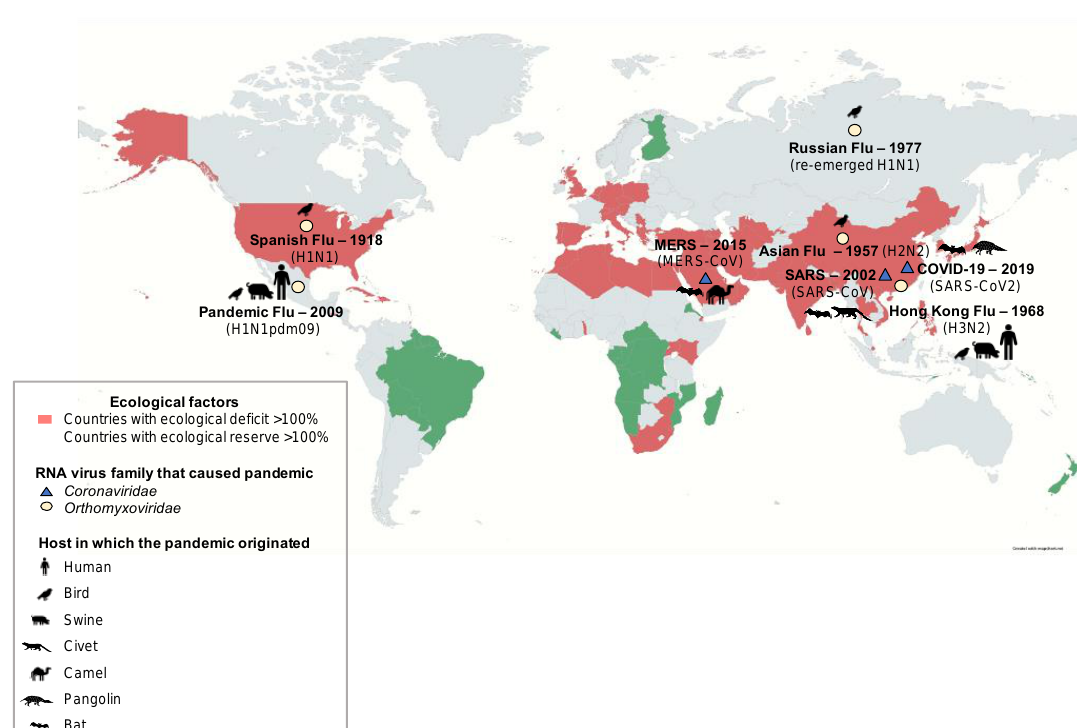
Figure 1. Countries with a percentage greater than 100% of ecological deficit (red) and countries with ecological reserve (green). The map indicates countries of origin of pandemics caused by RNA-genome viruses that belong to Coronaviridae (blue triangle) and Orthomyxoviridae (yellow circles) families. In the parenthesis are the viruses accountable for pandemics and pictograms represent the host(s) for each one of them. The year refers to the start date of the pandemic. Ecological data for deficit/reserve were taken from: Global Footprint Network, www.footprintnetwork.org (accessed on 7 December